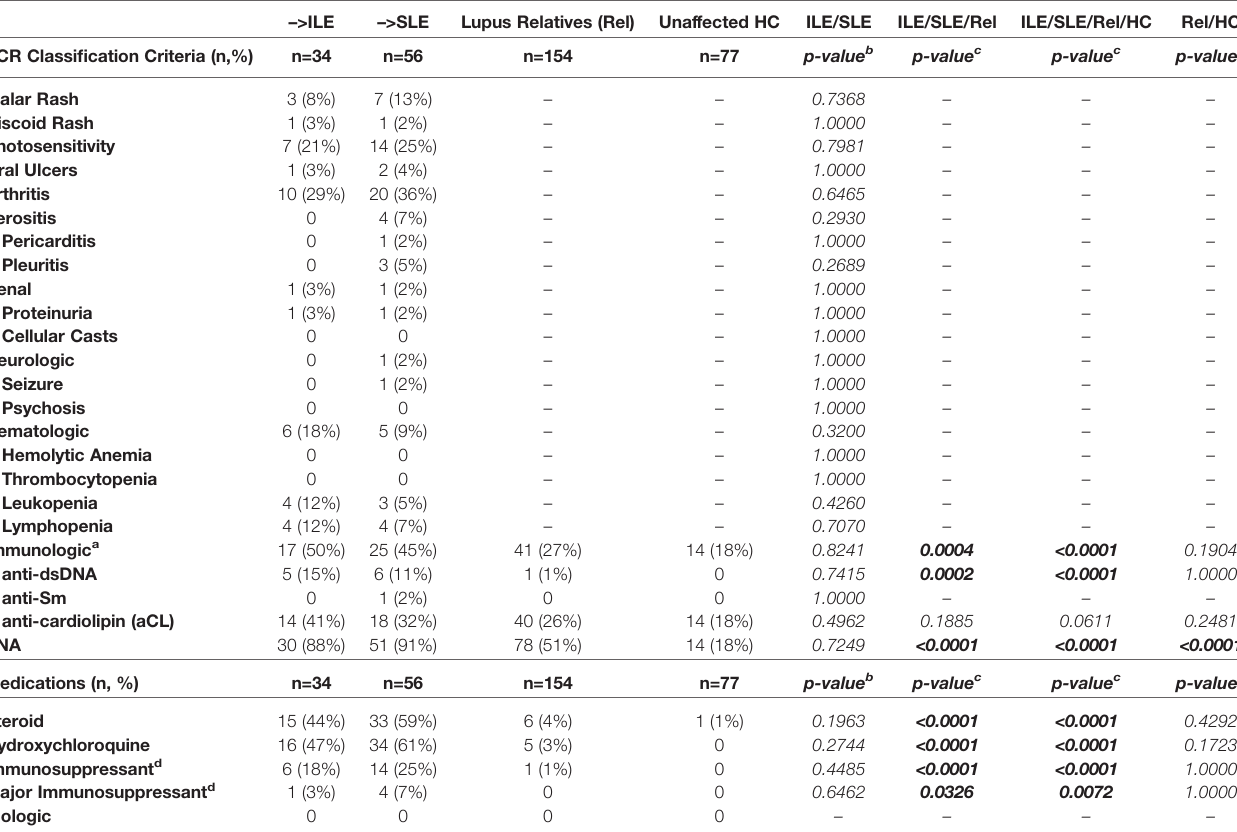
TABLE 3 | ACR Criteria and Medication in LAUREL Nested Cohort at Baseline (Prior to SLE